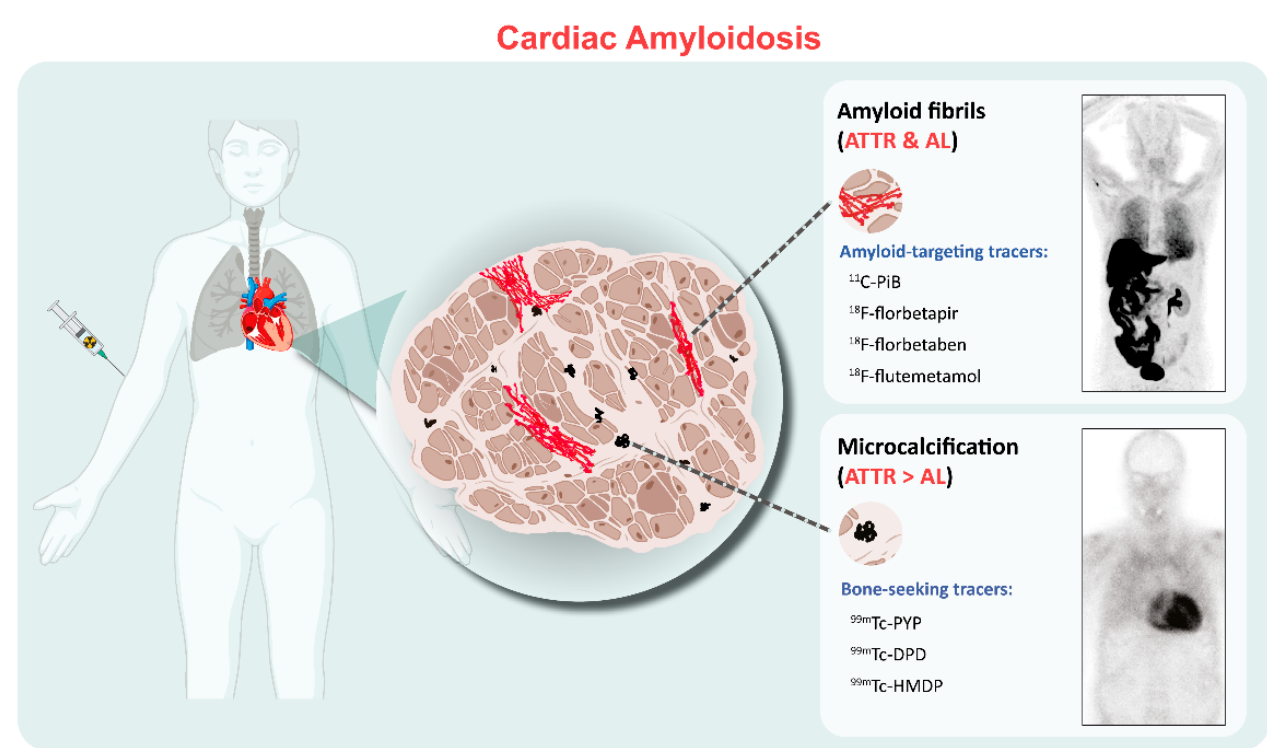
Figure 1. Binding properties of the clinically used radiotracers for cardiac amyloidosis. The amyloid- targeting PET tracers including 11 C-PiB and 18 F-florbetapir/florbetaben/flutemetamol bind to both AL and ATTR amyloid fibrils. SPECT bone-seeking tracers, including 99m Tc-PYP/DPD/HMDP, show more abundant uptake in ATTR than those in AL, possibly related to fibril microcalcification. Examples include 11 C-PIB PET/CT and 99m Tc-DPD scintigraphy images. PET= positron emission tomography; ATTR = transthyretin amyloidosis; AL = light-chain